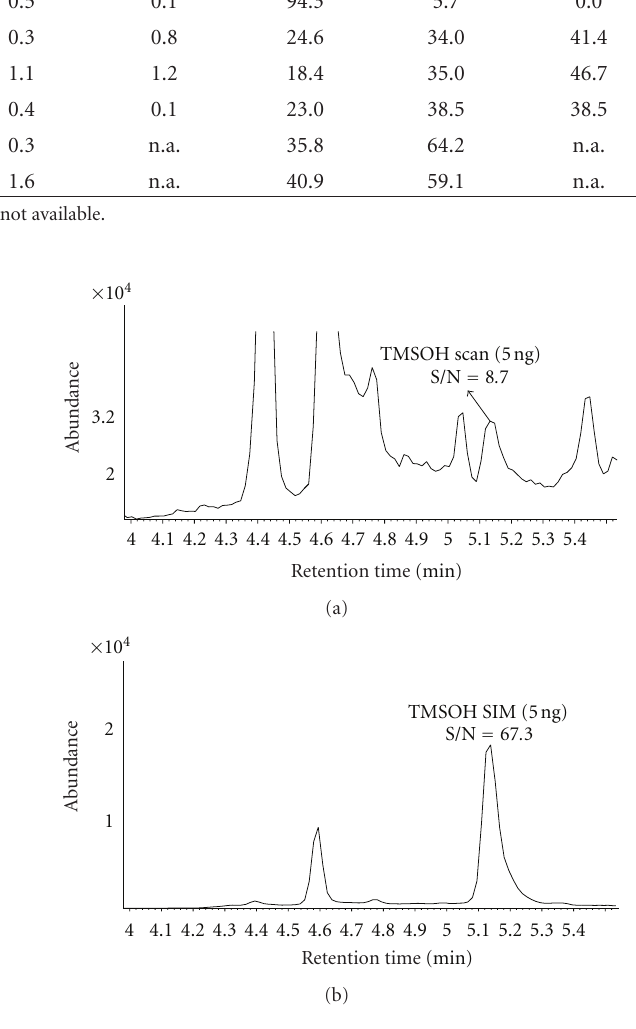
Figure 3: Total ion chromatograms showing signal-to-noise (S/N) ratios obtained from thermal desorption followed by GC-MS analysis of 5ng of TMSOH in (a) MS scan mode and (b) MS SIM